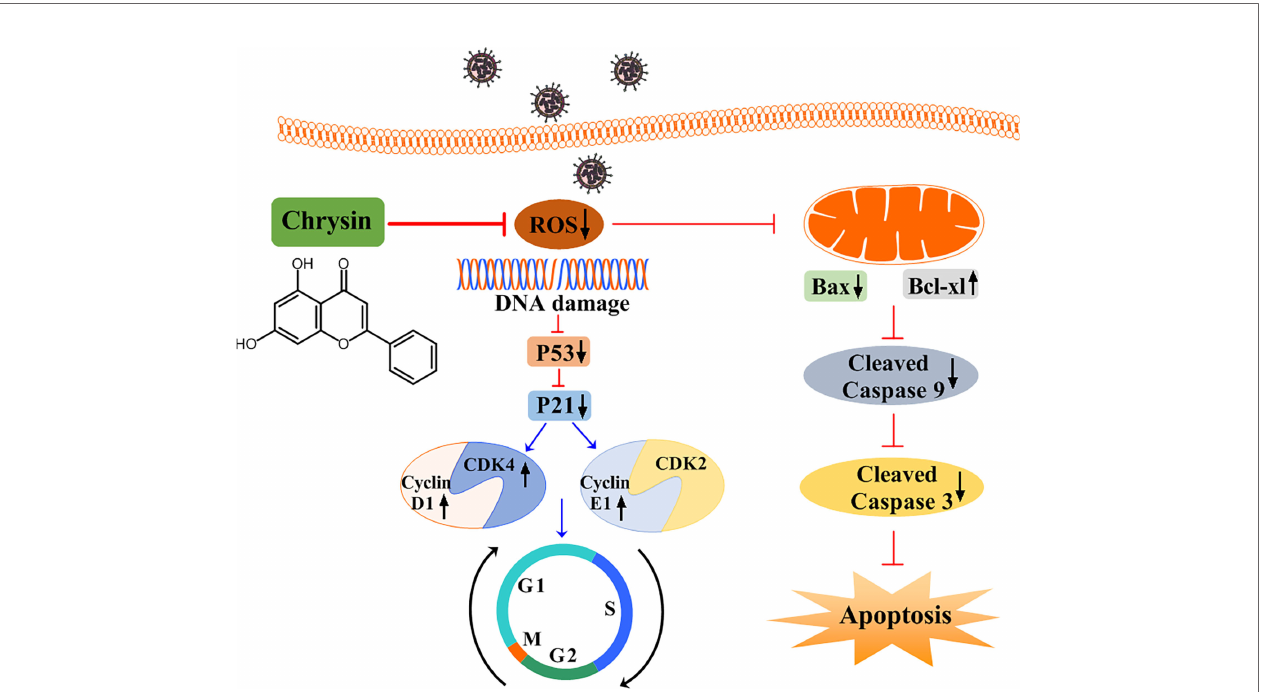
FIGURE 9 | A schematic diagram of the role of chrysin in suppressing in fl uenza virus infection by blocking G0/G1 cell cycle arrest and the mitochondrial apoptosis pathway. Chrysin restrains in fl uenza virus infection by disrupting ROS-mediated dual signaling pathways, including the suppression of p53 and p21, which promotes the activation of CDK4, Cyclin D1, and Cyclin E1, culminating in the prevention of cell cycle arrest at the G0/G1 phase. Alternatively, chrysin can reduce ROS- mediated Bax while increasing Bcl-xl, which in turn blocks mitochondrial apoptosis by inhibiting cleaved-caspase 9 and cleaved-caspase